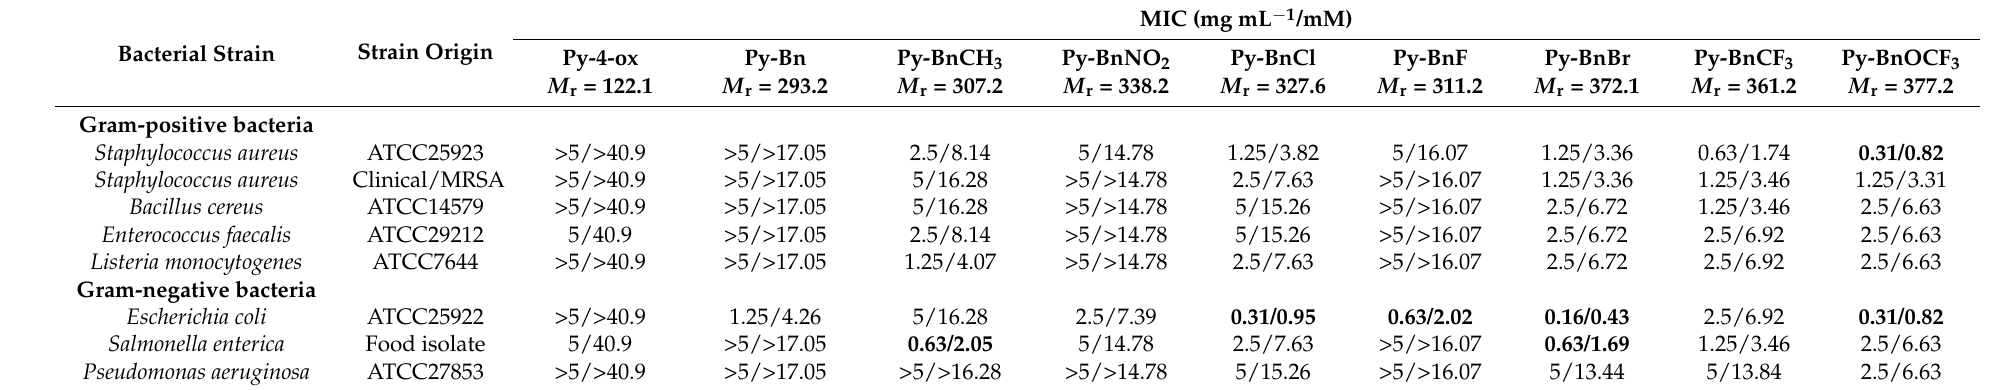
Table 1. Antibacterial activities of benzylated derivatives of pyridinium-4-aldoxime. The minimal inhibitory concentrations (MIC) are expressed in mg mL − 1 and mM units. MIC is the highest concentration of the compound required to suppress bacterial growth in three replicate experiments.